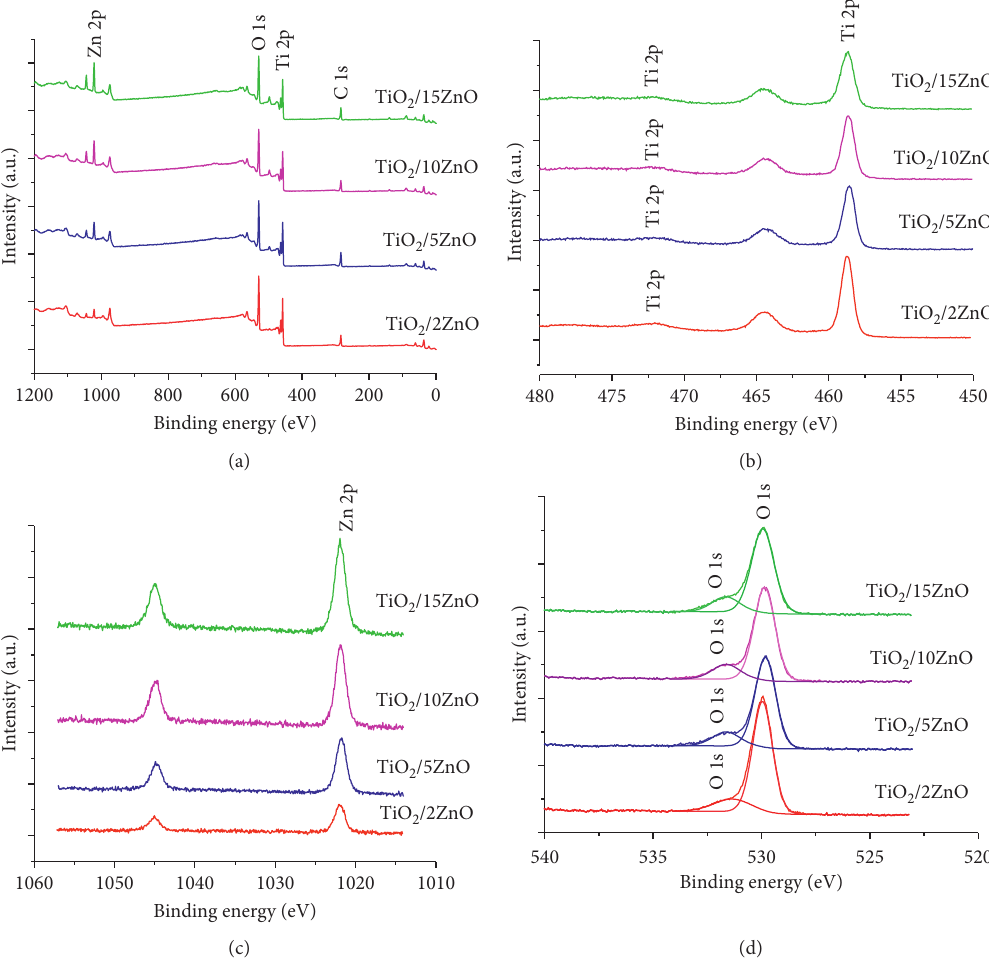
Figure 2: XPS spectra of TiO 2 -ZnO nanocomposites: (a) survey, (b) Ti 2p, (c) Zn 2p, and (d) O 1s.